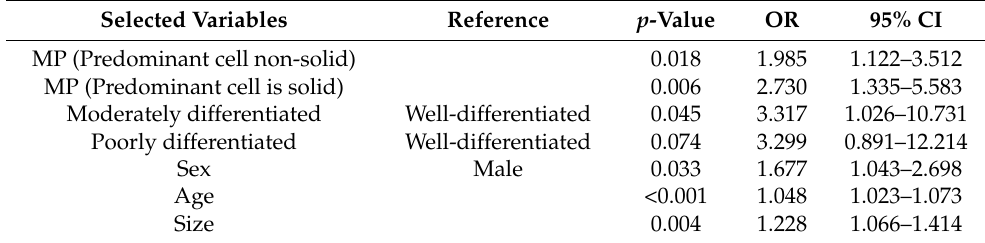
Table 3. Model with clinical variables only for the prediction of overall survival (C-index: